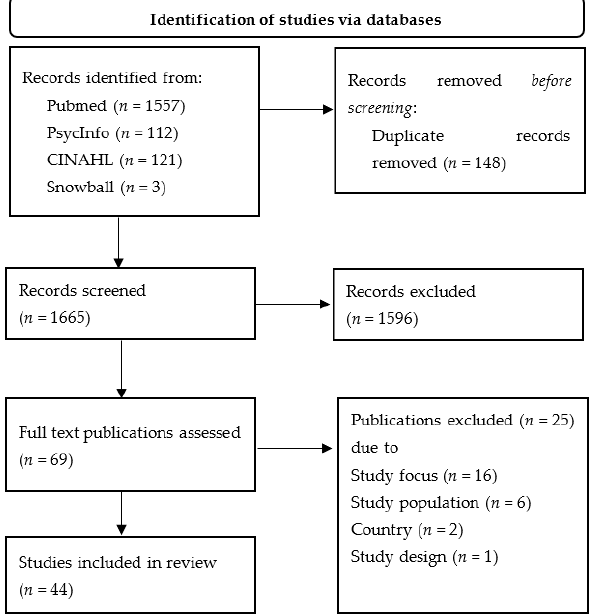
Figure 1. PRSIMA flow chart.